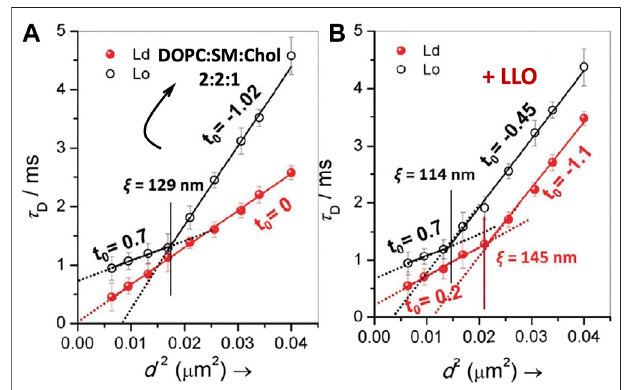
FIGURE 8 | Illustrates FCS diffusion law, τ d versus d 2 plots for DOPC: SM:Chol (2:2:1) in the absence (A) and in the presence of LLO (B) . In each panel, the transit time obtained from L o and L d regimes are represented by open and closed symbols respectively. The solid lines in the respective panels are the linear fi ts using Eq. 10 and the dotted lines represent the extrapolated fi ts to illustrate the intercepts. The vertical lines, in respective panels, demarcates the crossover length scale, ξ , separating different dynamical regimes. adapted from Sarangi and Basu